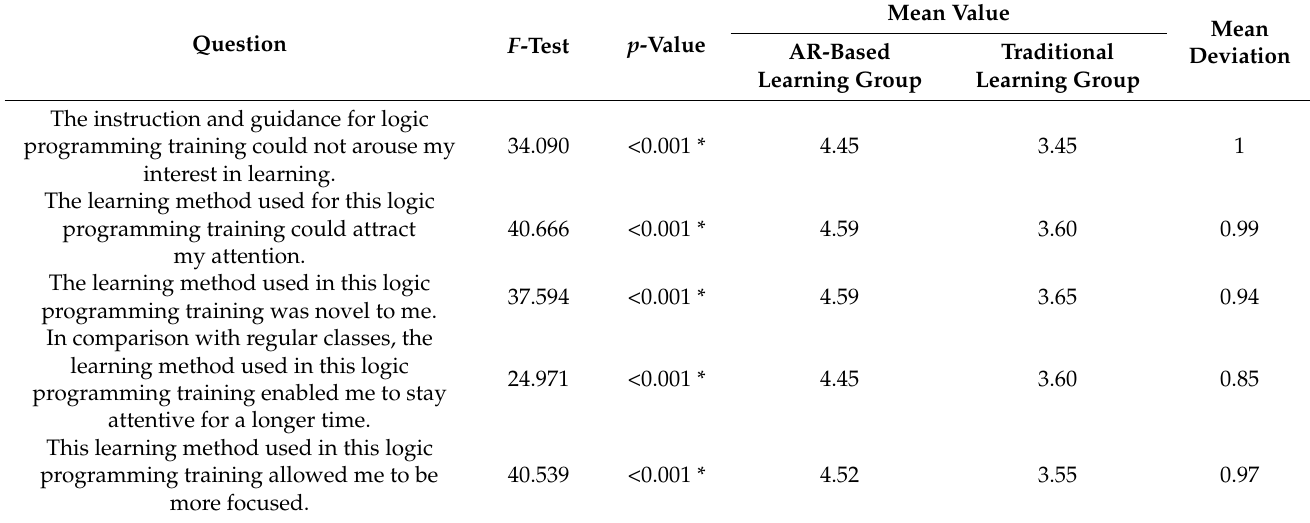
Table 9. Level of significance for each question in the Attention dimension.